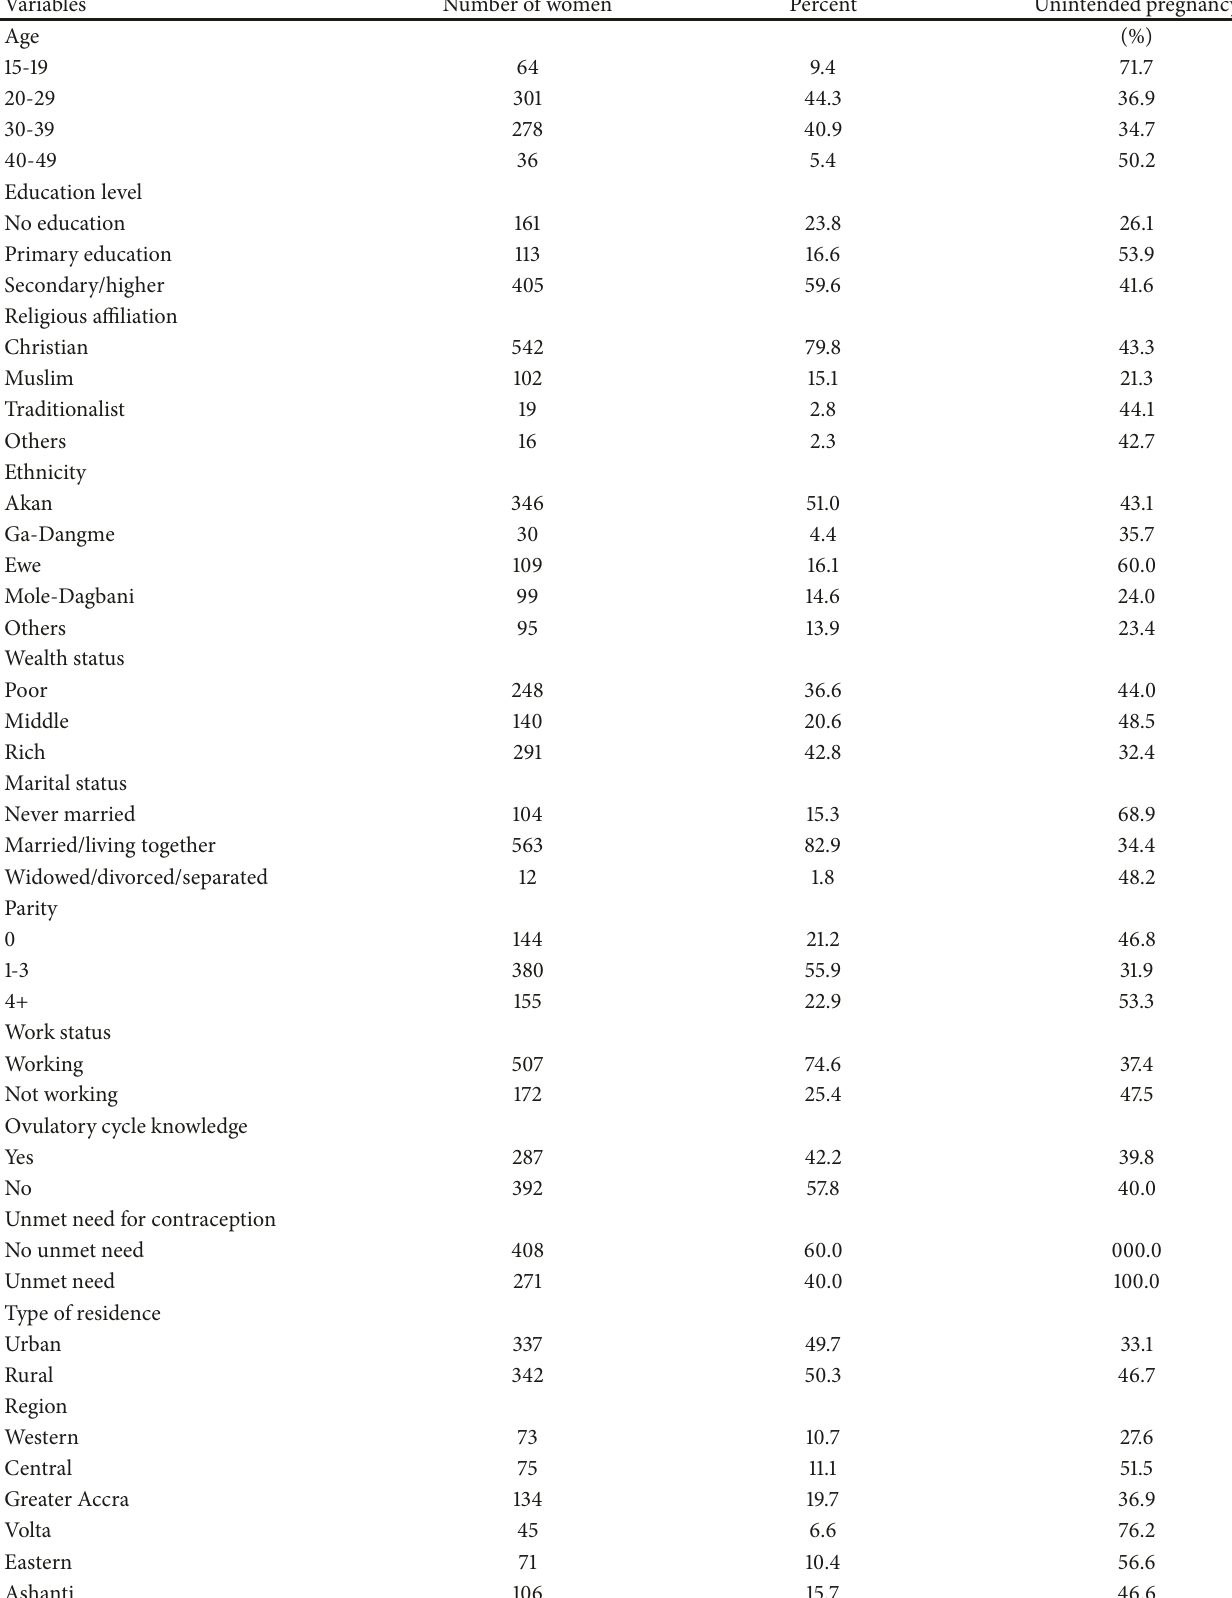
Table 1: Sociodemographic characteristics and prevalence of unintended